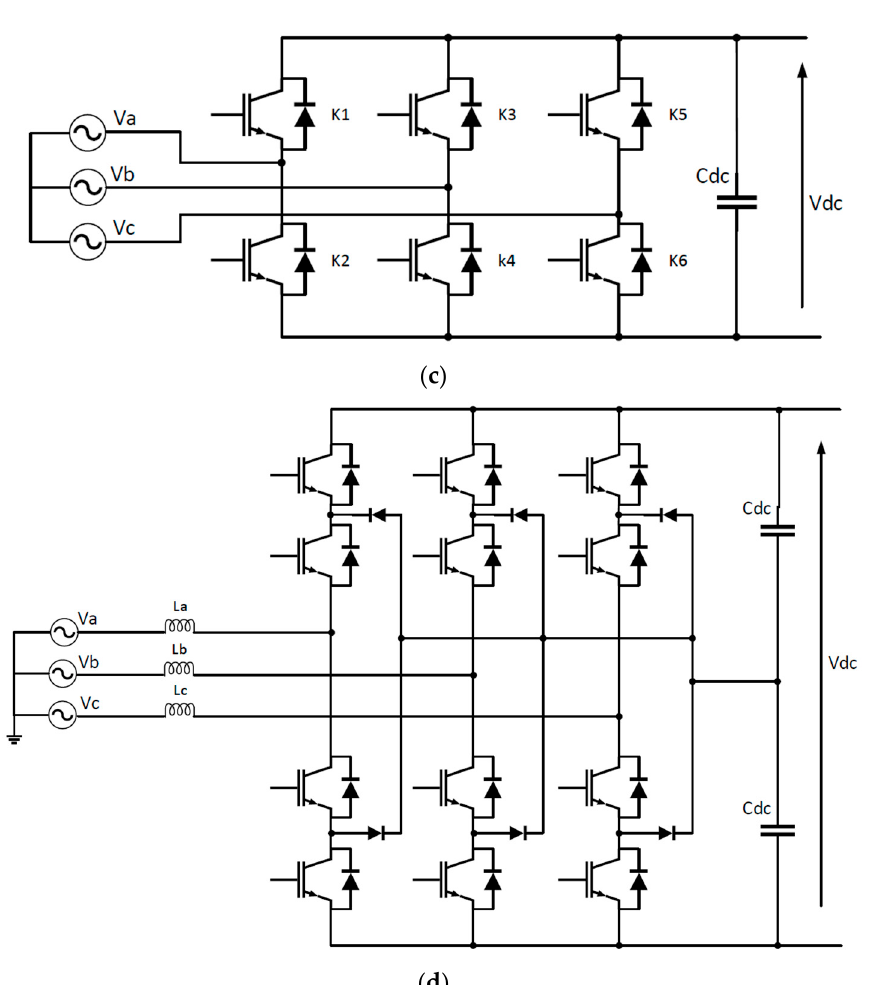
Figure 8. The electrical schematics of the commonly used bidirectional ac-dc power conversion stage in EV chargers: ( a ) Bidirectional half-bridge single-phase ac-dc power converter; ( b ) Bidirectional full-bridge single-phase ac-dc power converter; ( c ) Bidirectional three-phase ac-dc power converter; ( d ) Bidirectional three-level diode-clamped ac-dc power converter.